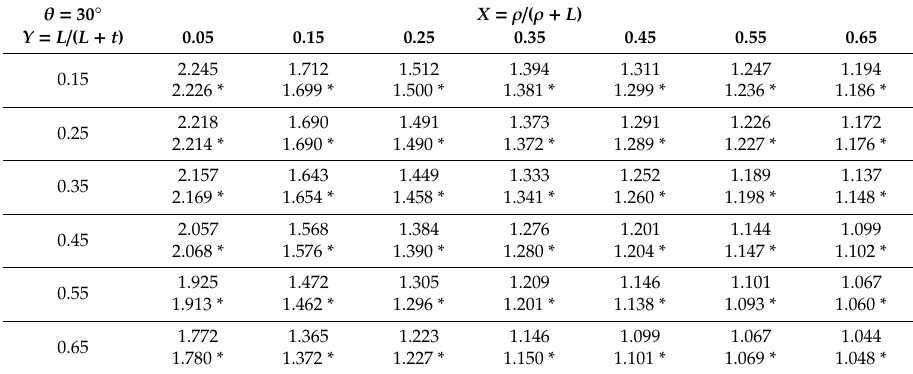
Table 4. Comparison of SCFs calculated using formula (A2) (*) to the FEM results for a Double-V butt-welded joint subjected to bending load, where θ = 30 ◦ .